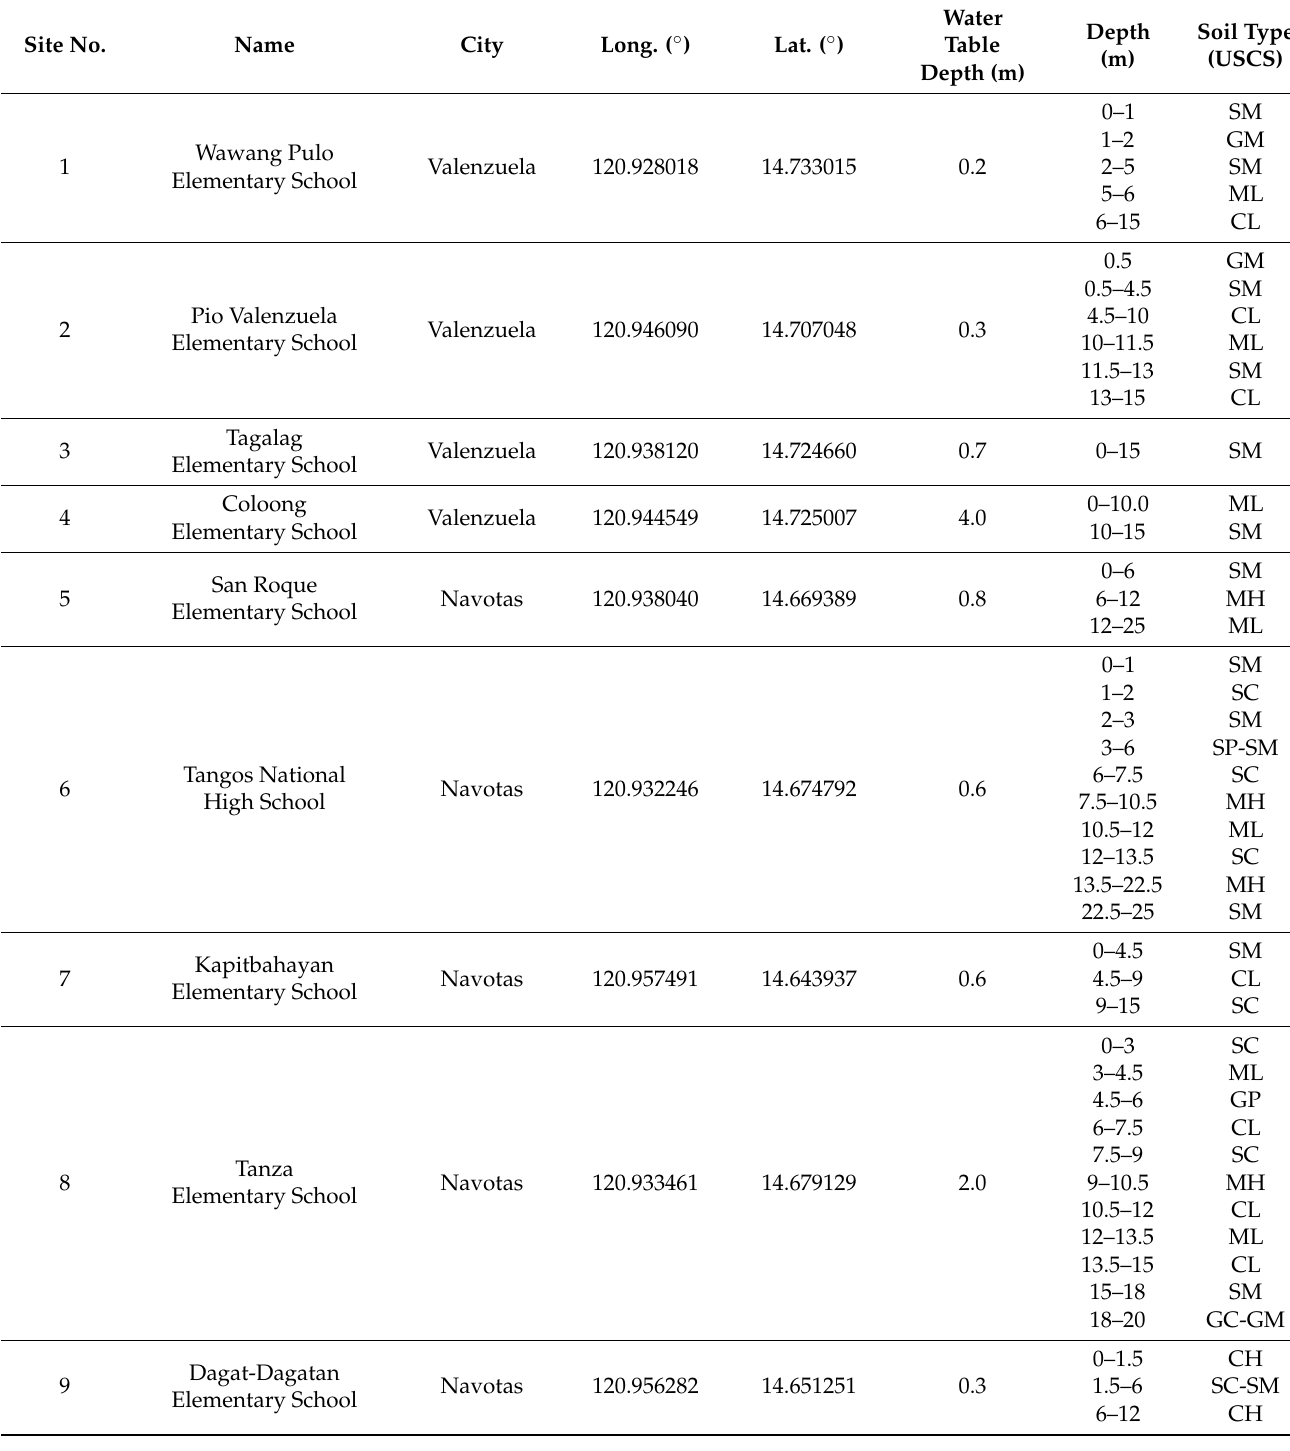
Table 1. Summary of the SPT from the twenty sites, indicating the location, water table depth, and Unified Soil Classification System (USCS) soil types at varying depths. The USCS scheme is adapted as the standard practice for soil classification for engineering purposes [46].